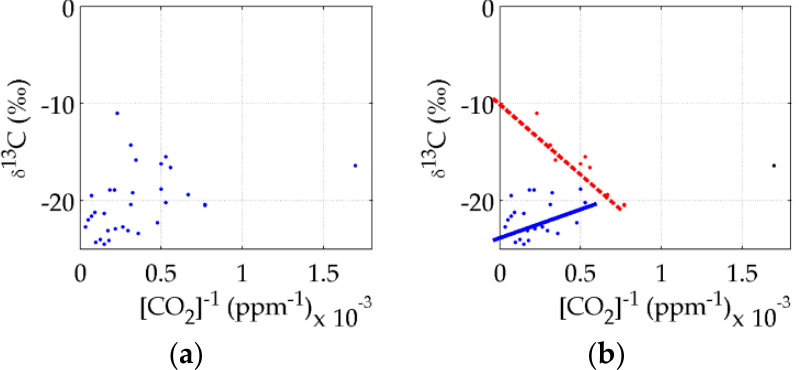
Figure 3. Keeling plot of isotope results from Godin Site. ( a ) Raw. ( b ) With interpretation.